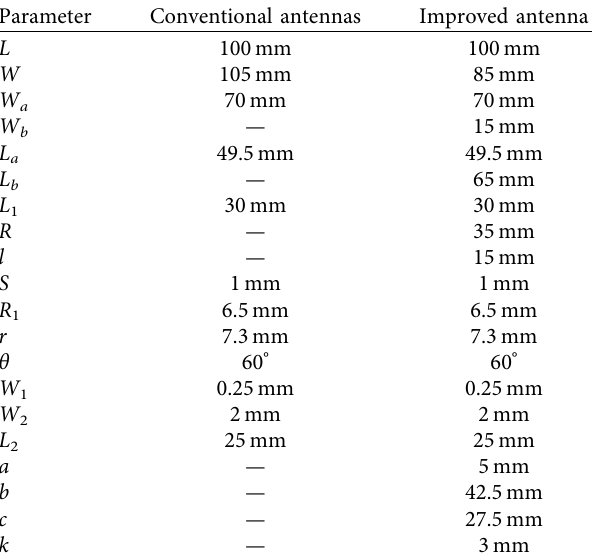
Table 1: Antenna